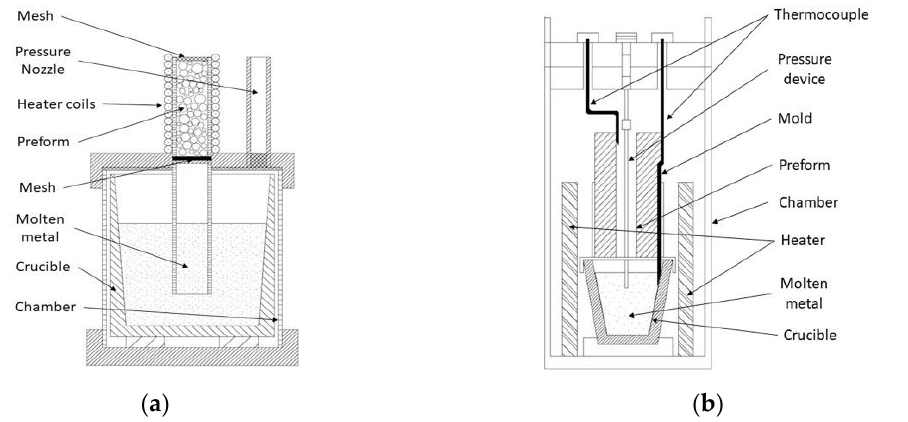
Figure 3. ( a ) Schematic view of the CGIG equipment adapted from Orbulov [82]; ( b ) CGIG set-up adapted from Rohatgi et al. [96].